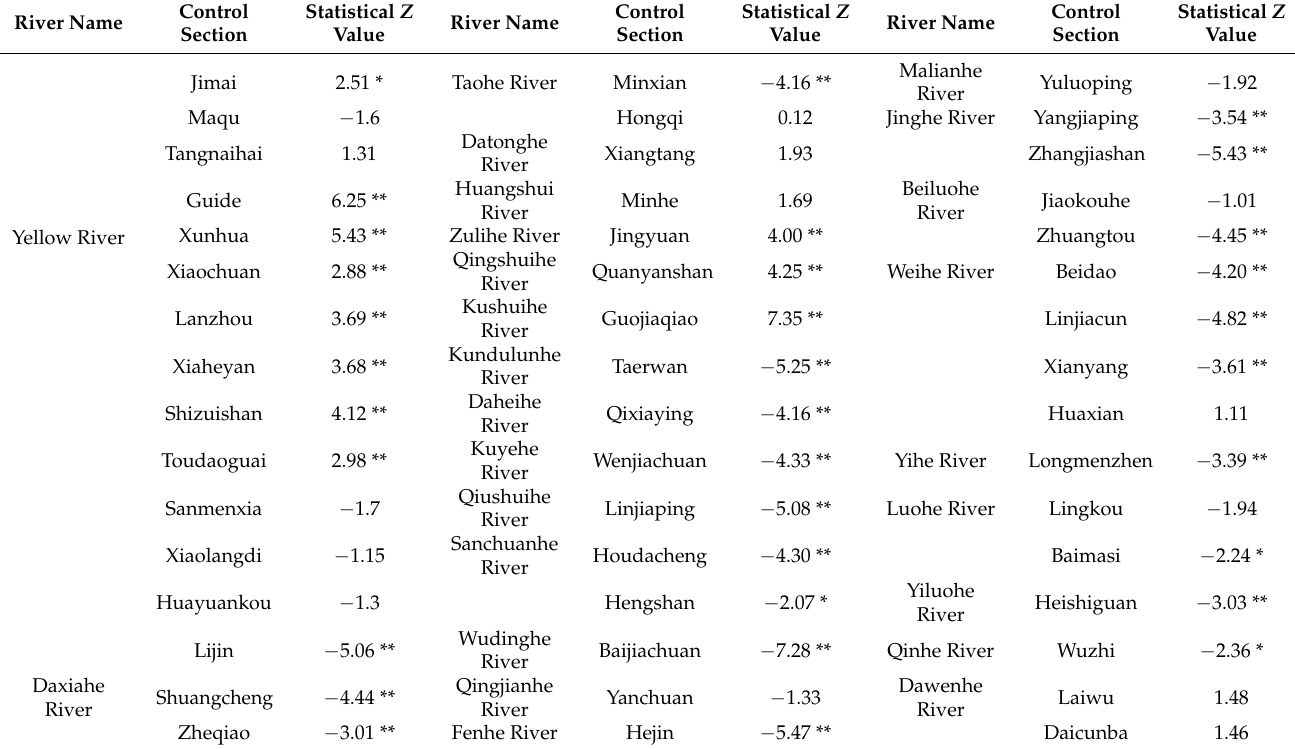
Table 3. Interannual variation of runoff at main control sections of the Yellow River Basin in dry